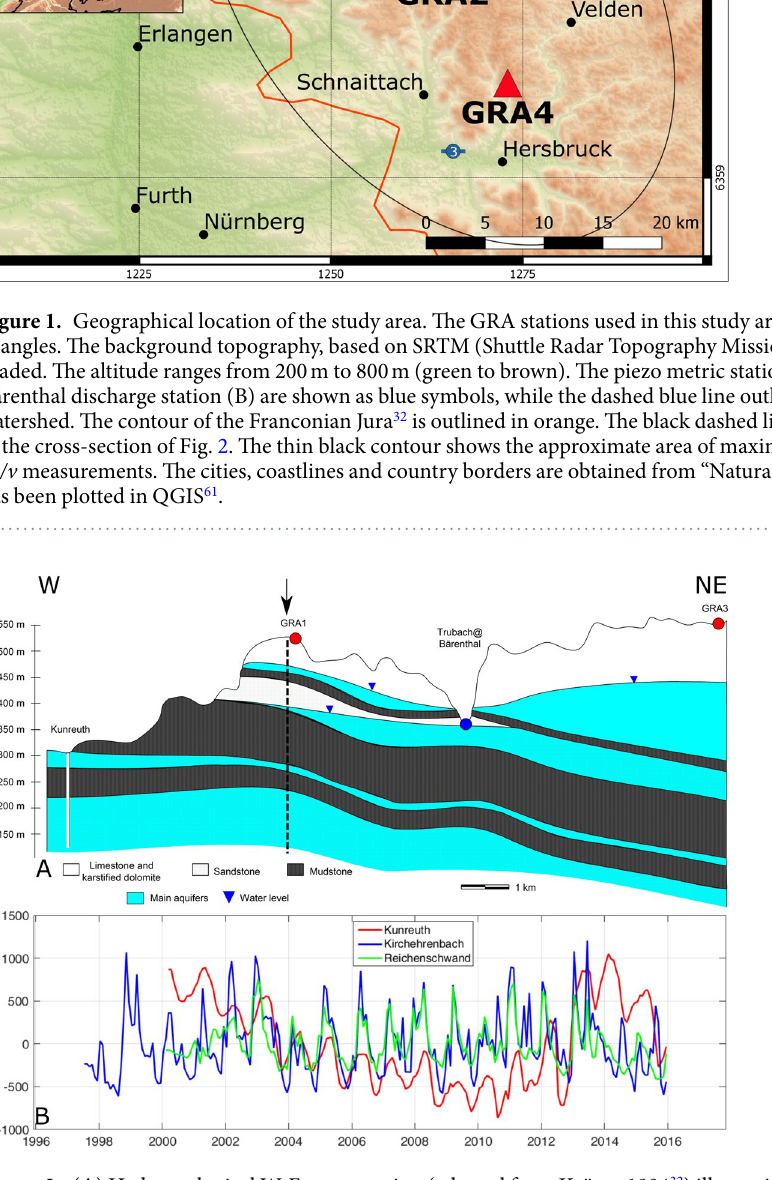
frequencies would increase the vertical resolution, they are dominated by non-stationary and unknown anthro- pogenic sources. A detailed description of the data and of the seismic noise at Gräfenberg is given the Methods section.